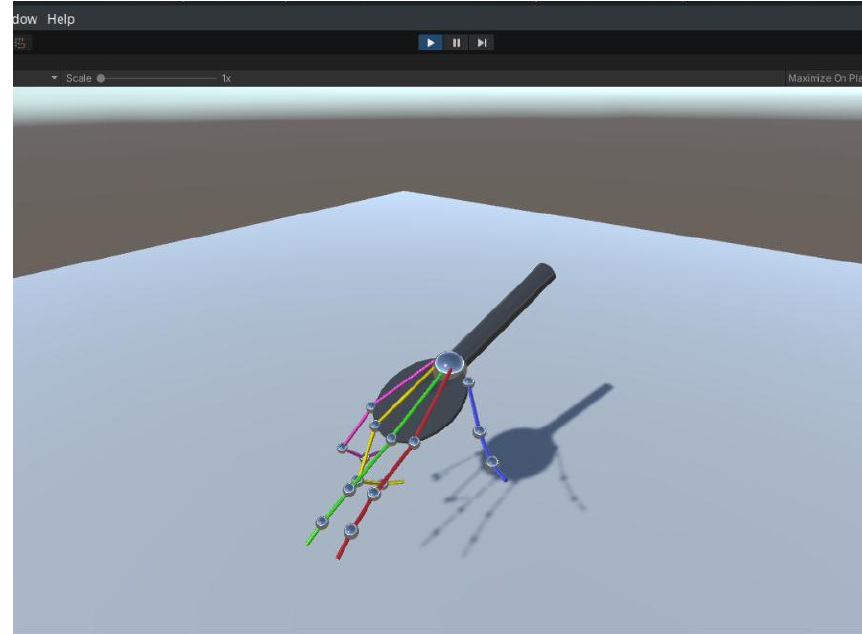
Figure 10. Two fingers simulation.